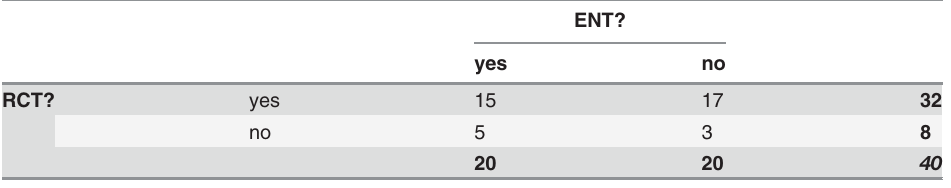
Table 2. Assessment of retrieved articles in general medical